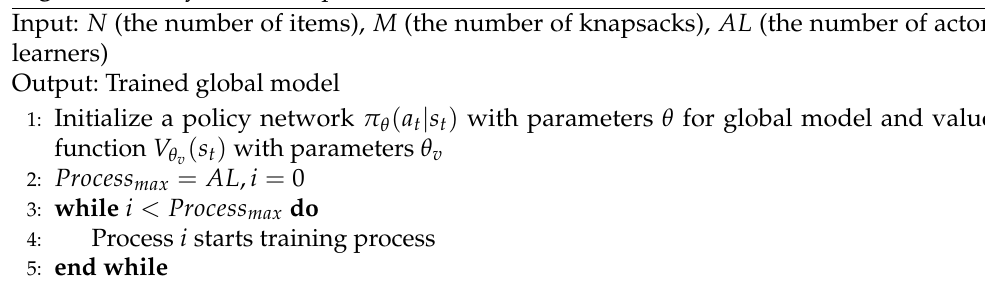
Algorithm 1 Asynchronous